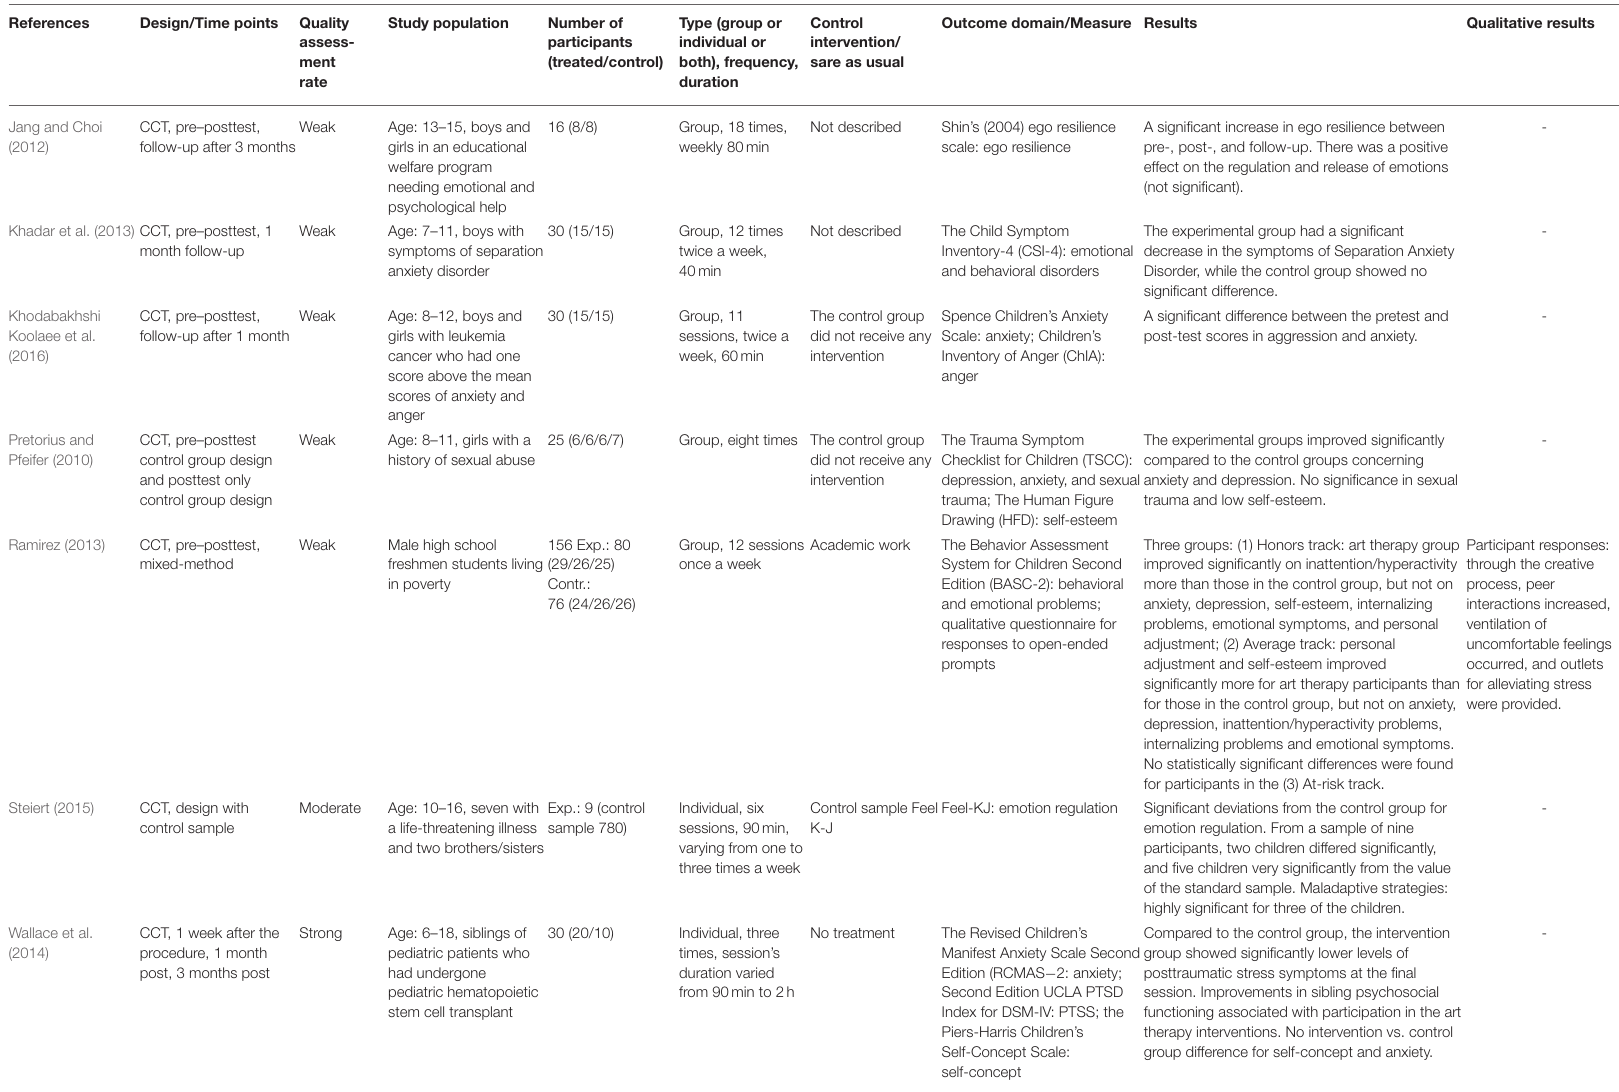
Age: 7–11, boys with symptoms of separation